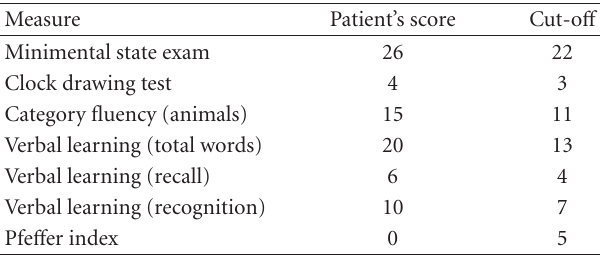
Table 1: Patient’s cognitive screening (January